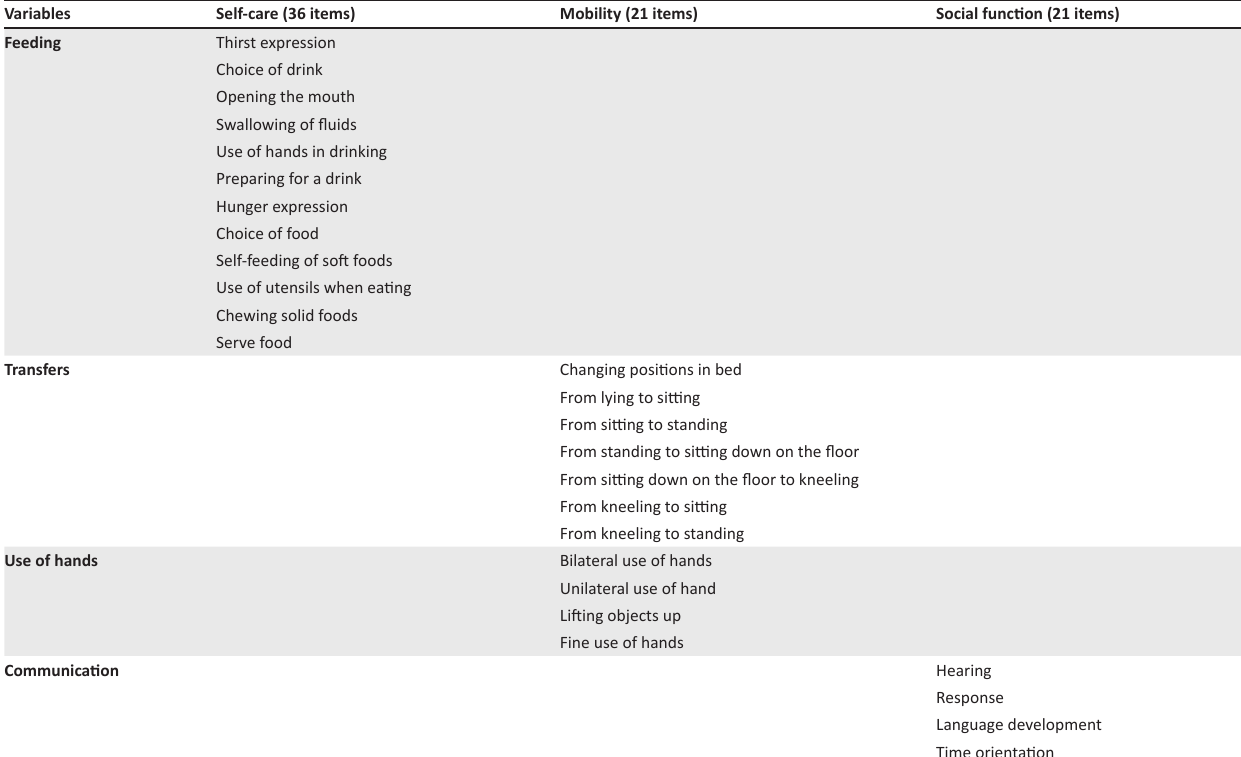
TABLE 6: The 78 items identified for the content validity evaluation.